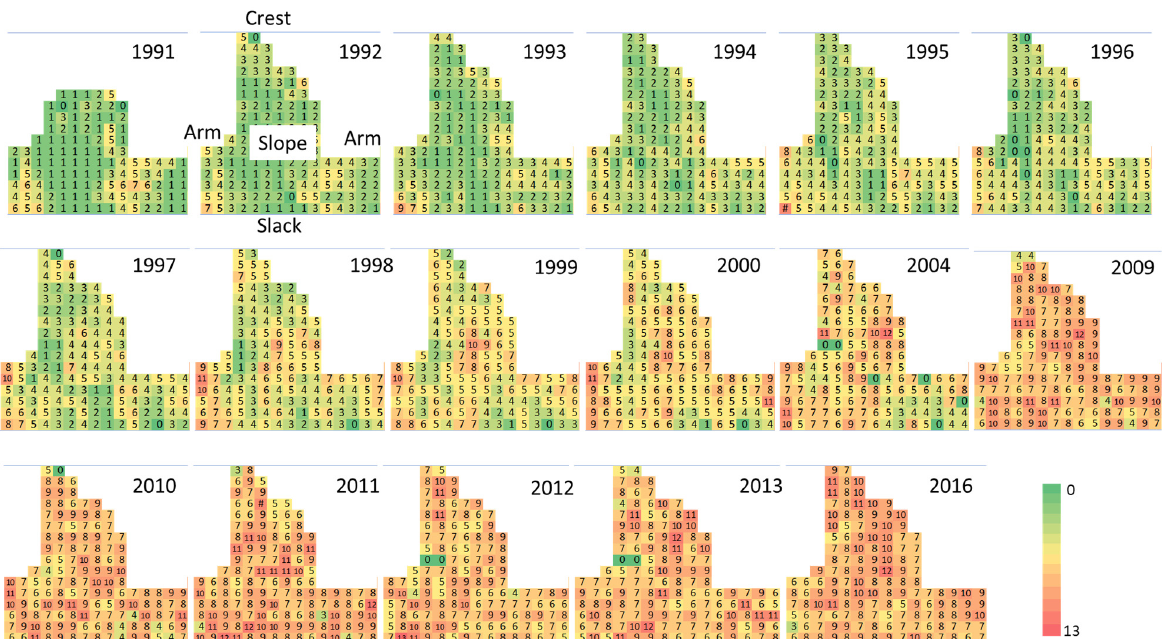
Figure 5. Spatial and temporal patterns of plant species richness during a 25-year successional sequence on mobile coastal dunes in Veracruz, located in the central region of the Gulf of Mexico. Numbers and colors represent species richness. Figures represent the spatial distribution of the plots within the mobile dunes area.